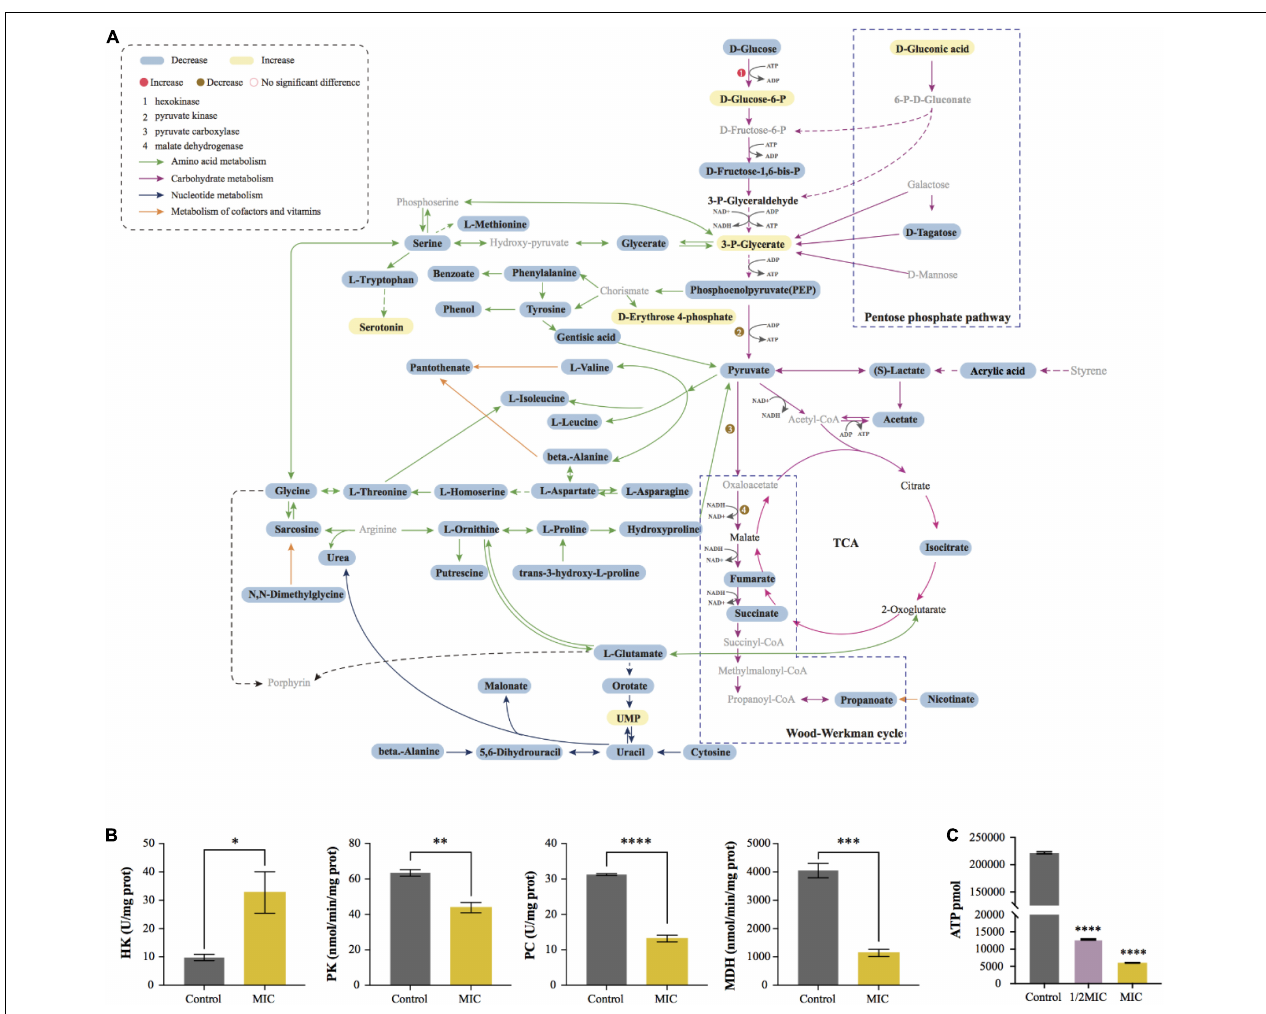
FIGURE 7 | Visualization of metabolic pathway and changes of key enzyme activity and ATP content before and after EO treatment. (A) Summary graph of metabolic pathways in MIC group (vs. Control). The black fonts indicated the detected metabolites (blue boxes were significantly down-regulated differential metabolites, yellow boxes were significantly up-regulated metabolites, and the rest are not differential metabolites), while the gray fonts indicated undetected metabolites. The activities of Hexokinase (HK), Pyruvate kinase (PK), Pyruvate Decarboxylase (PC) and Malate Dehydrogenase (MDH) are shown in (B) . (C) Effect of EO on ATP synthesis in C. acnes